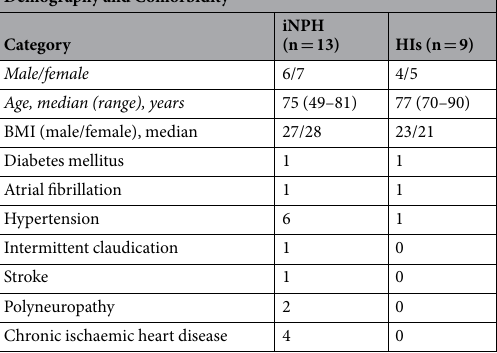
Table 1. Clinical characteristics of the iNPH patients and